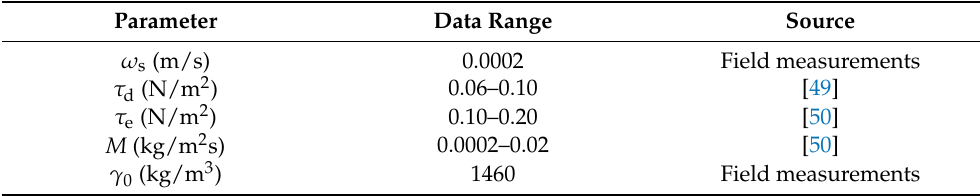
Table 3. Parameter values adopted in the model.